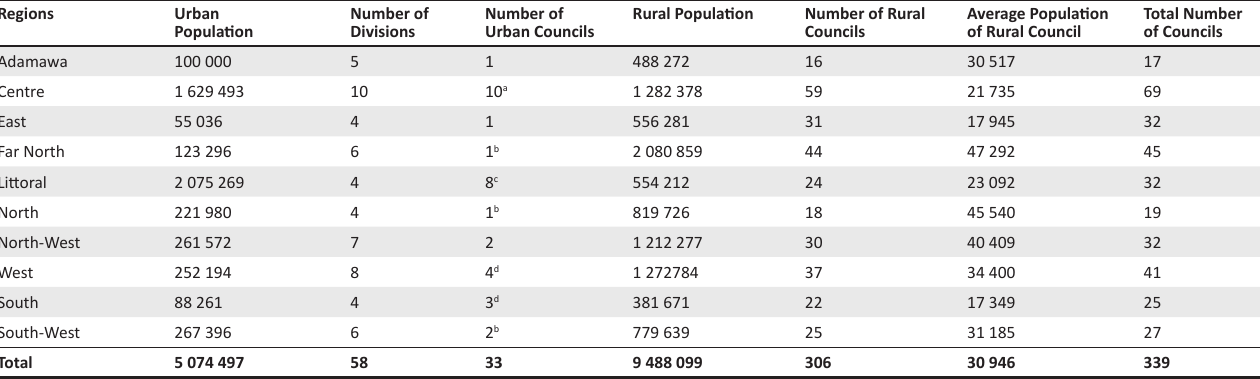
TABLE 1: Local government distribution by regions and population distribution by council types in Cameroon.